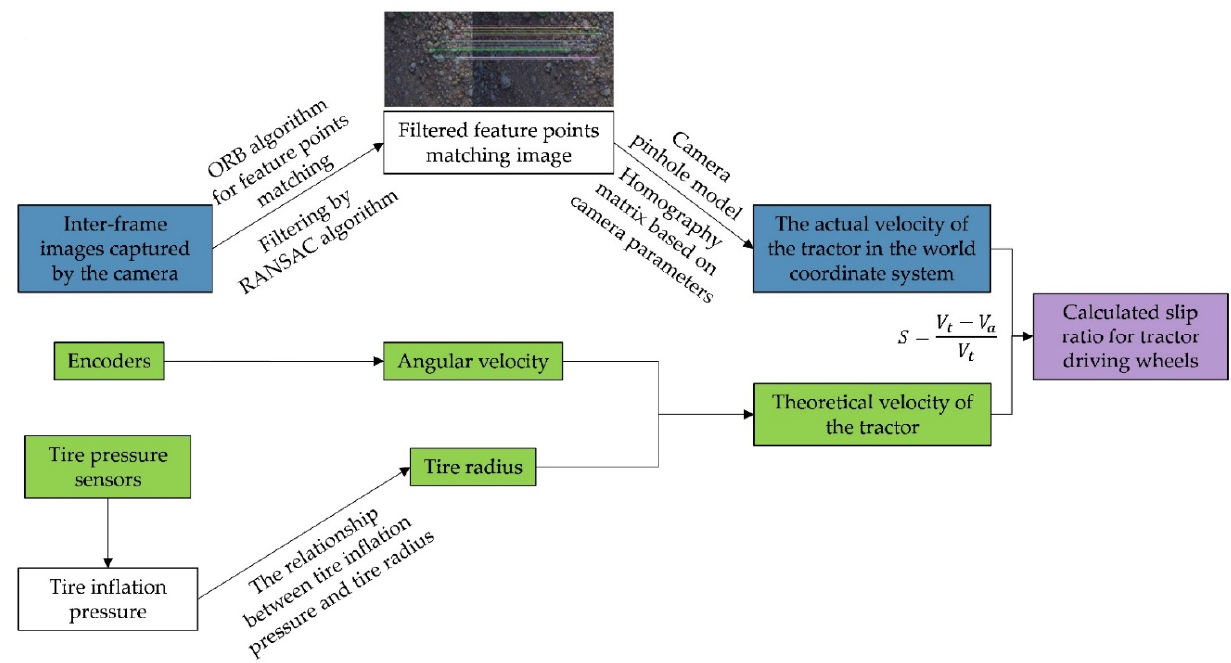
Figure 7. System diagram of measuring slip ratio for tractor drive wheels.